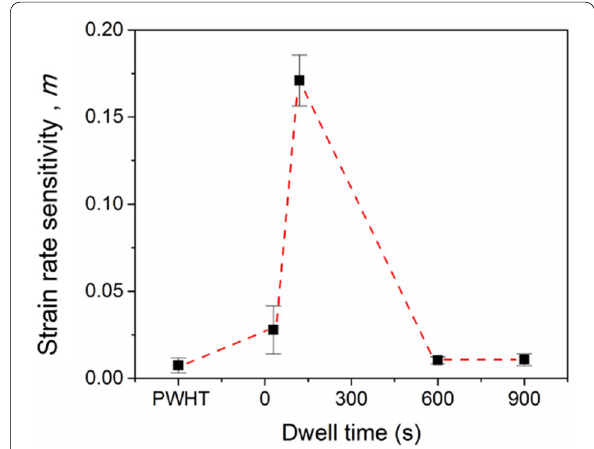
Figure 14 Variation in SRS ( m ) for fracture edge in the P92 steel welded joint with different dwell